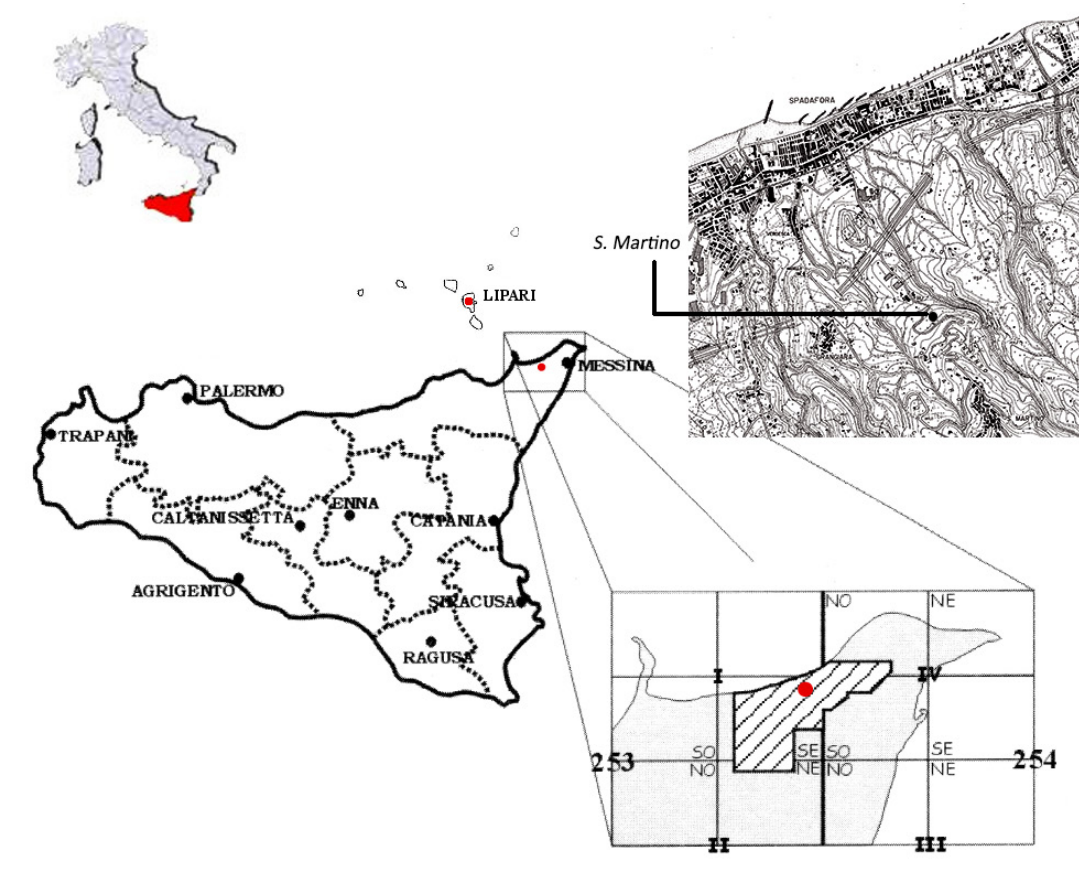
Figure 1. S. Martino site position (IGM map of Spadafora) compared to Lipari island. The Neolithic settlement (Martinelli & Quero, 2013) situated on an alluvial deposit made of sand and gravel, where a few streams used to flow, was probably connected with a seasonal stream which was active in winter, at the eastern side of the site. The excavation carried out on an area of 160 square meters has highlighted the presence of a settlement near these streams, during two phases of the Neolithic period: the early one in the Middle Neolithic period (Stentinello culture) and the latest one in the Late Neolithic (Diana culture). There were some hearths, fragmented and whole pottery and a large amount of burned daub fragments that attest the wattle and daub technique used for the construction of huts. The stratigraphic sequence of the phase of occupation and abandonment of the site started underneath the layer 1 sloping to the north (Figures 2, 3; Table